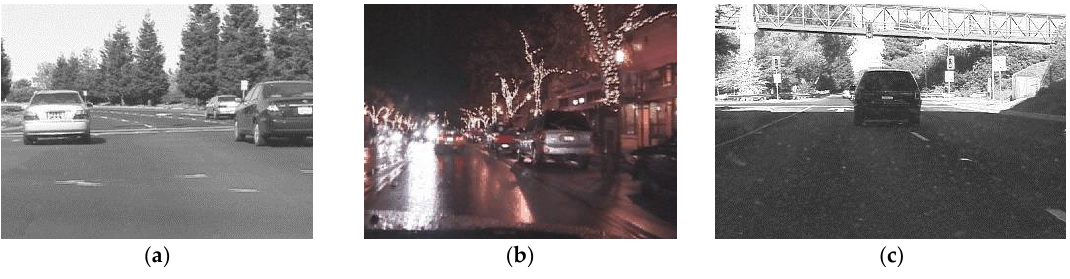
Figure 4. Examples of different video scenarios: ( a ) Open field in daytime; ( b ) Open field at night; ( c ) Covered field in daytime.